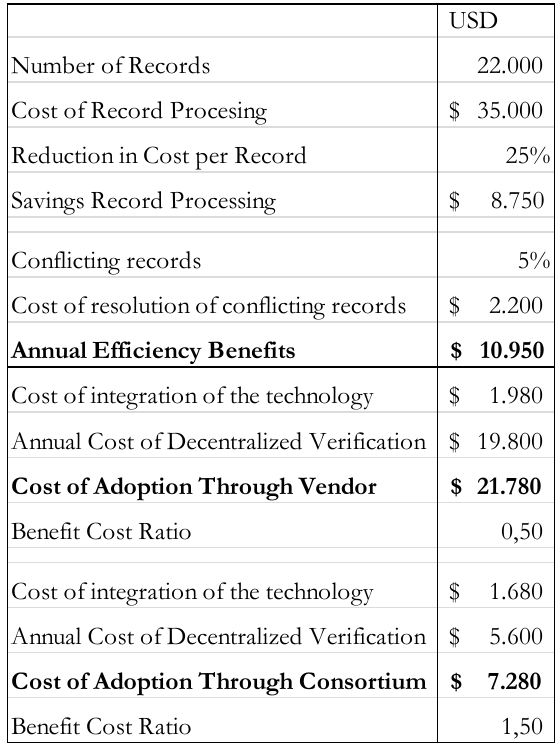
Table 3: Cost-benefit analysis for universities adopting a decentralised verification system based on blockchain